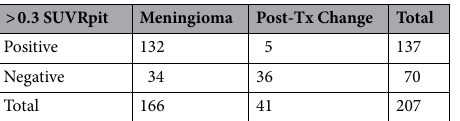
Table 4. Contingency table for the SUVRpit method at the optimal threshold of 0.3.